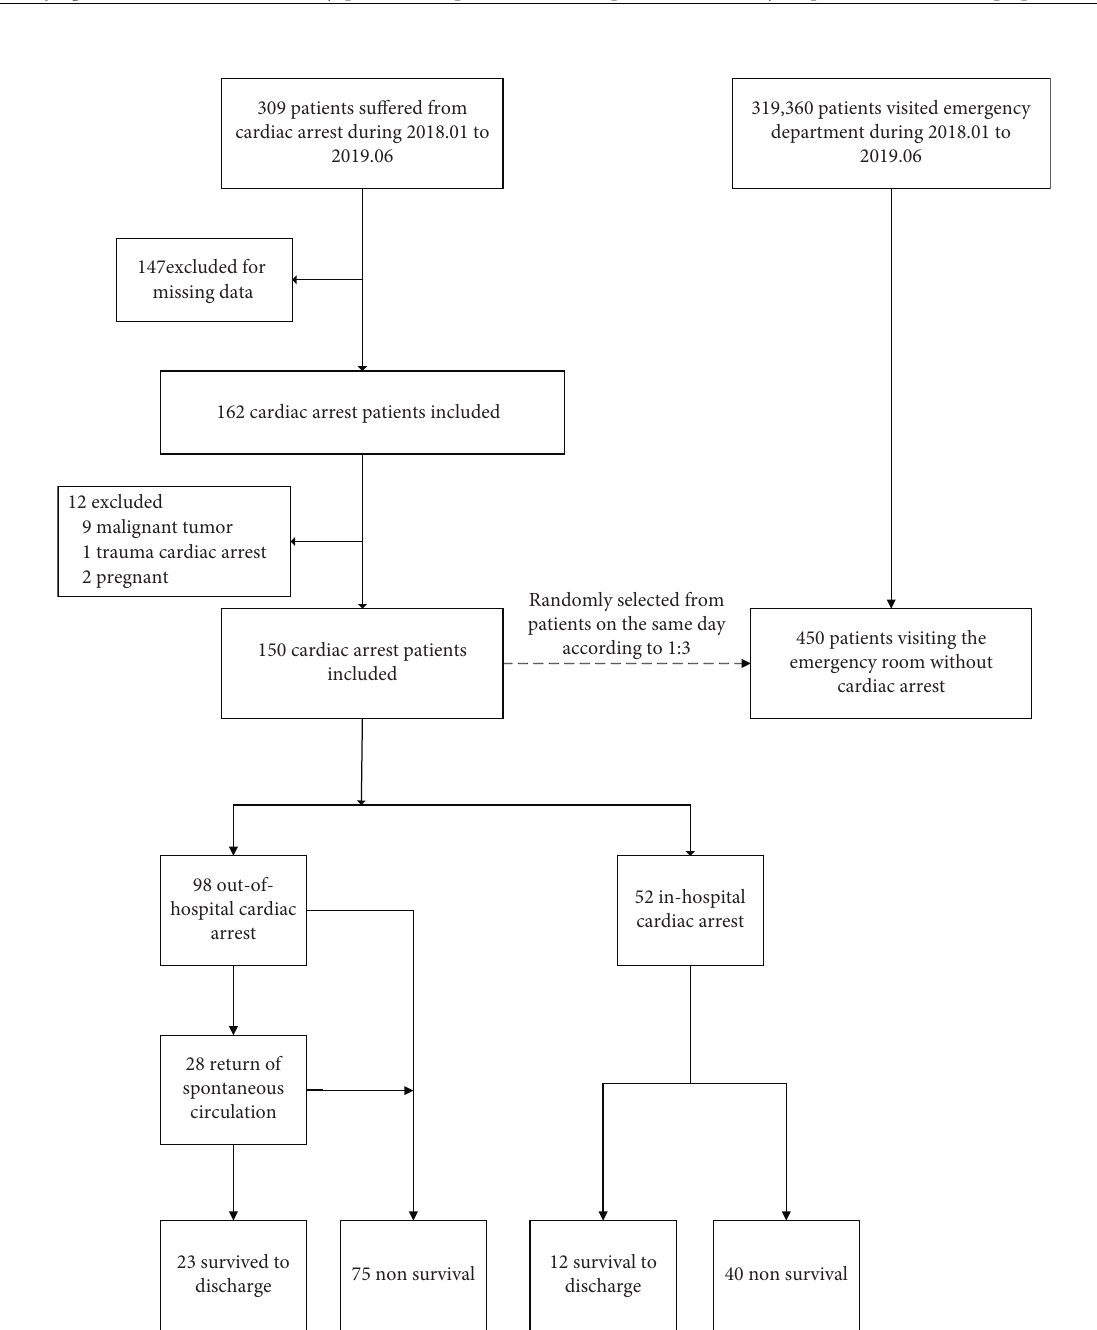
Figure 1: Te patients’